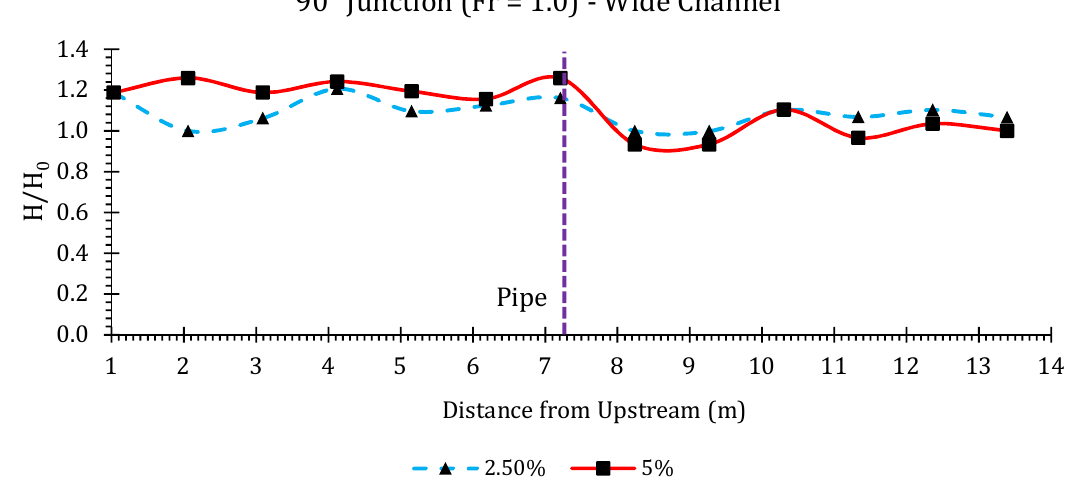
Figure A6. Water height ratios in a 90° junction for Fr = 1.0 in the wide channel.